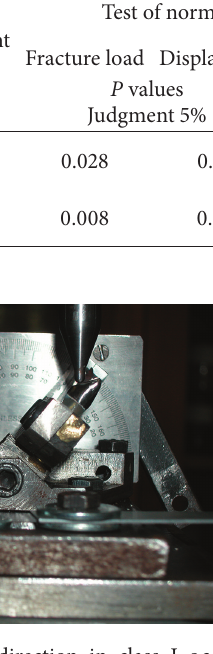
Figure 7: Simulating clinical direction in class I occlusion for testing.